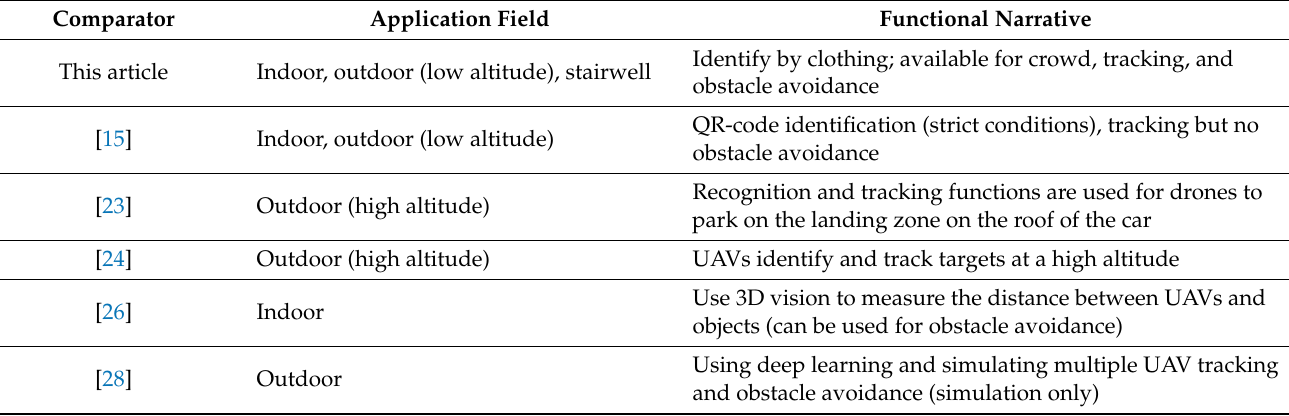
Table 3. Feature comparison